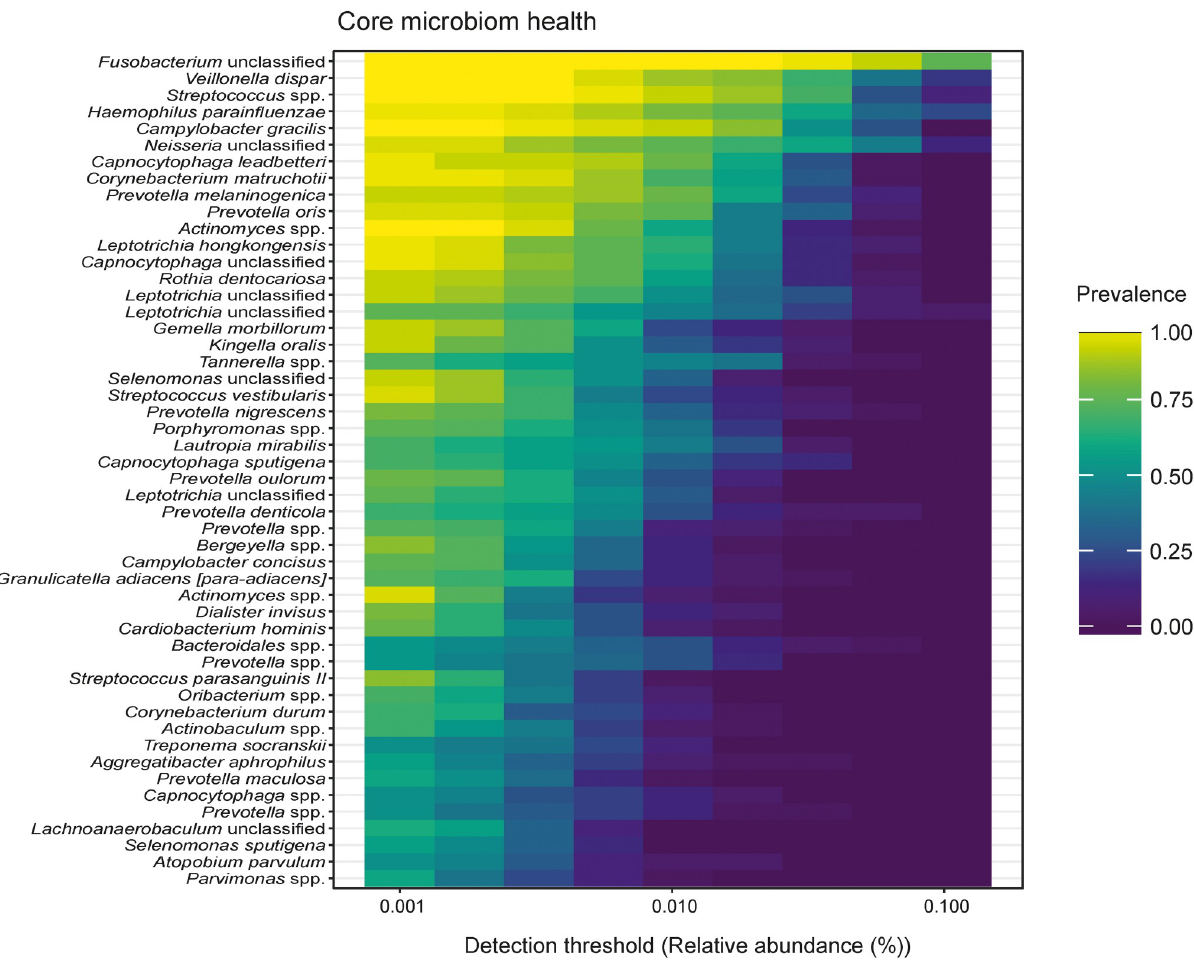
Fig 2. Heat map of the core microbiome in health. The healthy core microbiome is displayed by a heat map that identifies Fusobacteria unclassified, Veillonella dispar , Streptococcus spp., Haemophilus parainfluenzae , Campylobacter gracilis , Neisseria unclassified, Capnocytophaga leadbetteri , Corynebacteriuim matruchotii , Prevotella melaninogenica , and Prevotella oris as the ten most prevalent species.